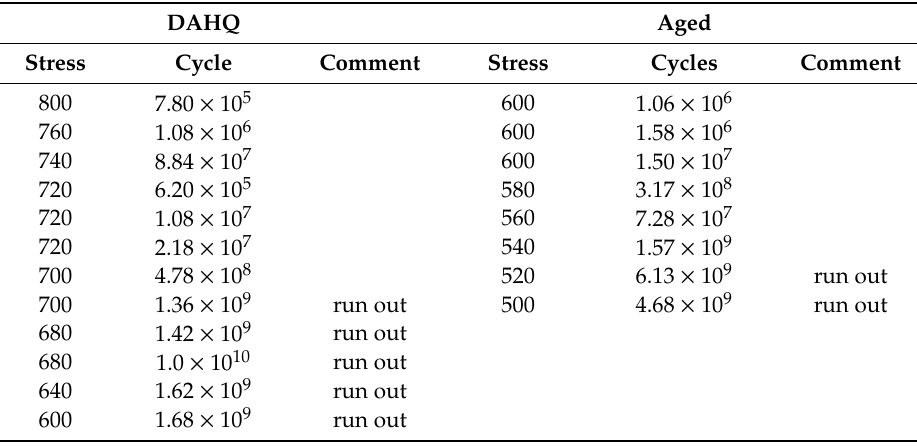
Table A1. Relationship between applied stress and number of cycles tested at 20 kHz.